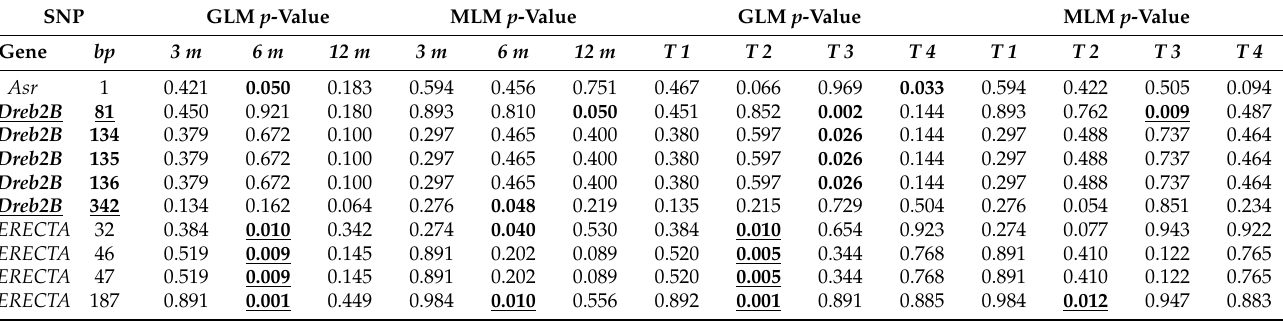
Table 3. Habitat drought stress significant correlations with SNP polymorphisms at Asr2 , Dreb2B , and ERECTA -encoding candidate genes for drought tolerance in tepary bean s.l. ( P. acutifolius – parvifolius clade). Habitat drought stress (Table S2) was computed as a drought index ( DI ) using Thornthwaite’s evapotranspiration model at three, six, and 12 months as well as trimester timeframes ( T1 to T4 ). Environmental correlations with each candidate gene were determined using generalized, mixed, and compressed mixed (GLM, MLM, and CMLM) linear models accounting for population stratification via an IBS kinship matrix as implemented in Tassel v5.0. Only significant associations are depicted; their p -value estimates are bolded ( p -value < 0.05) and underlined ( p -value ≤ 0.01), the latter a FDR equivalent for a candidate gene design [63]. SNPs in coding regions are in bold, and non-synonymous